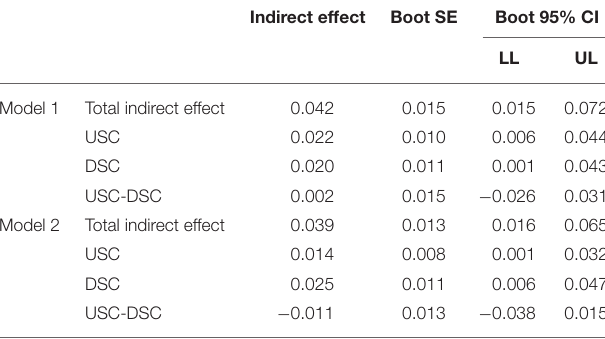
TABLE 2 | Indirect effects with upward and downward social comparisons as